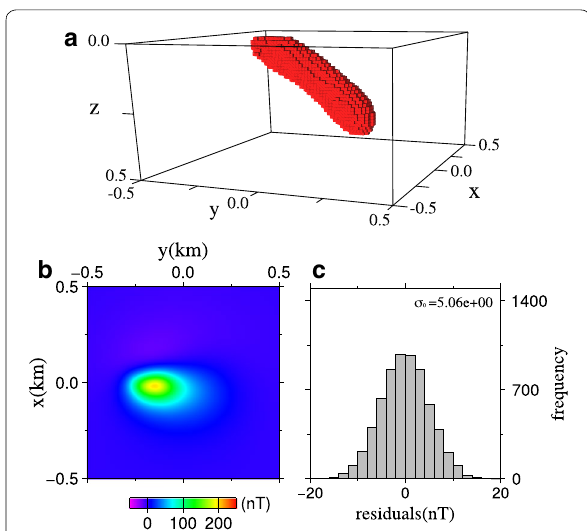
Fig. 18 An optimal model derived by L1–L2 norm regularized inversion. An optimal model derived by L1–L2 norm regularized α S 2 0.90 using weighting function w S 2 . a A inversion with ˆ = perspective view of the optimum model which displays all non-zero model elements, b total field anomaly computed by this model, and